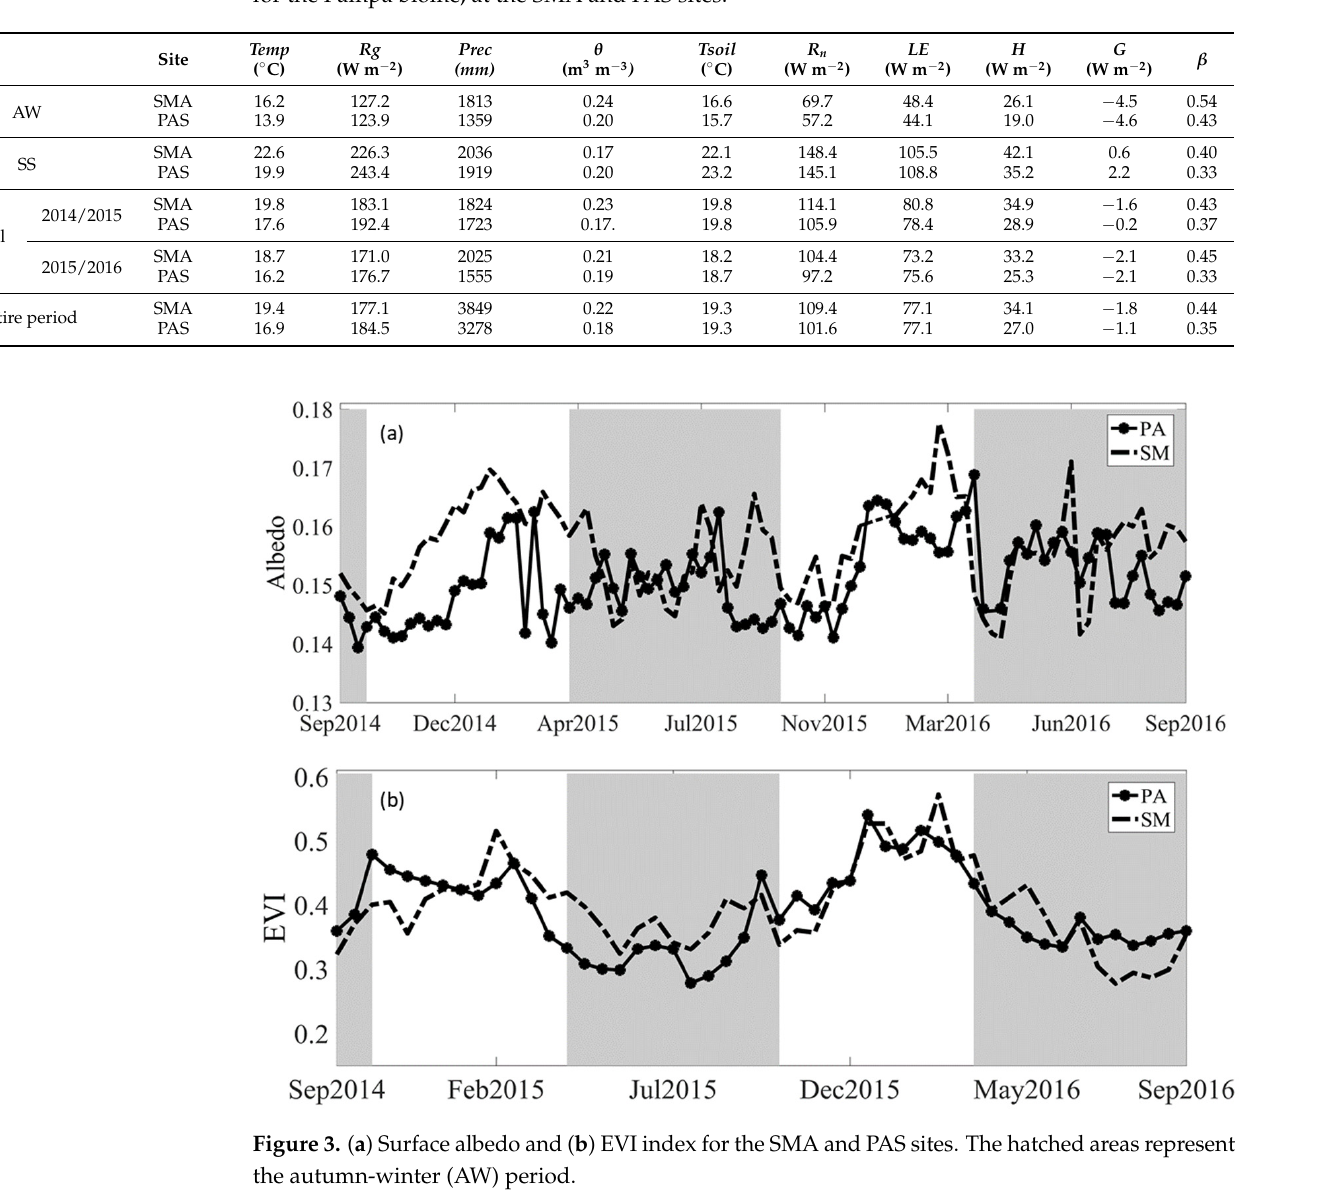
Figure 3. ( a ) Surface albedo and ( b ) EVI index for the SMA and PAS sites. The hatched areas represent the autumn-winter (AW)